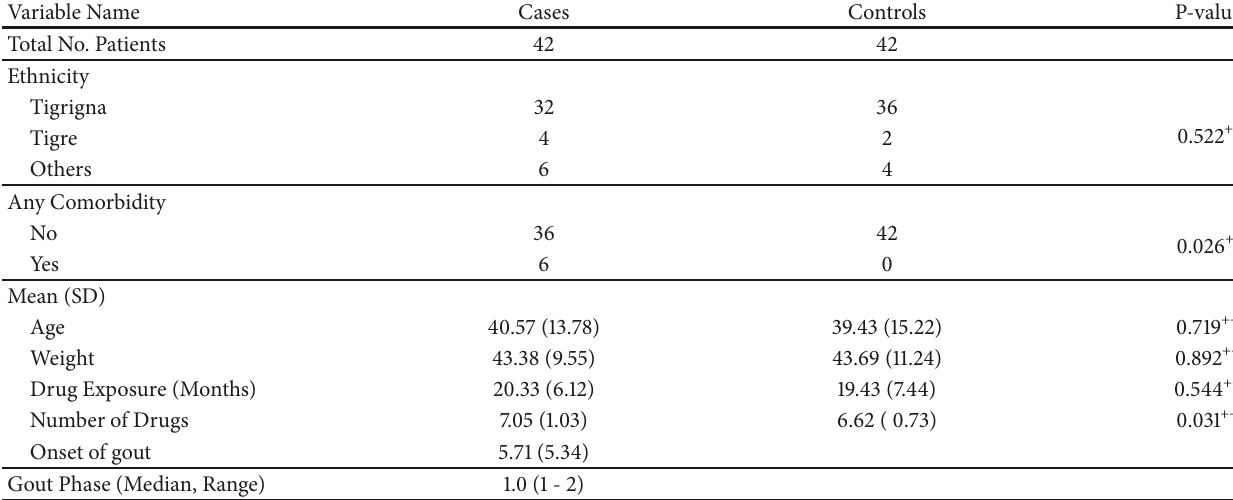
Table 1: Comparing the baseline characteristics of the case and control